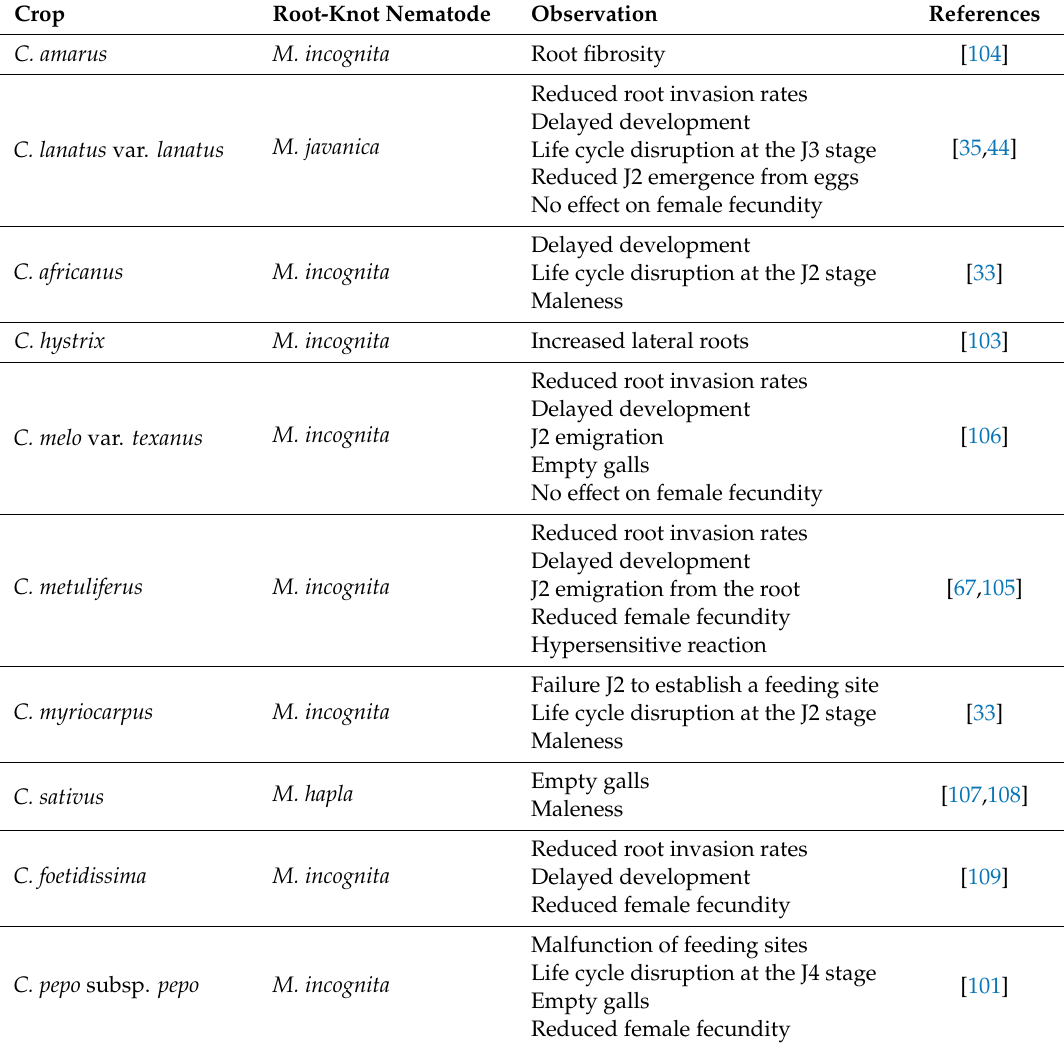
Table 3. Mechanisms of resistance to root-knot nematodes in cucurbitaceous crops.